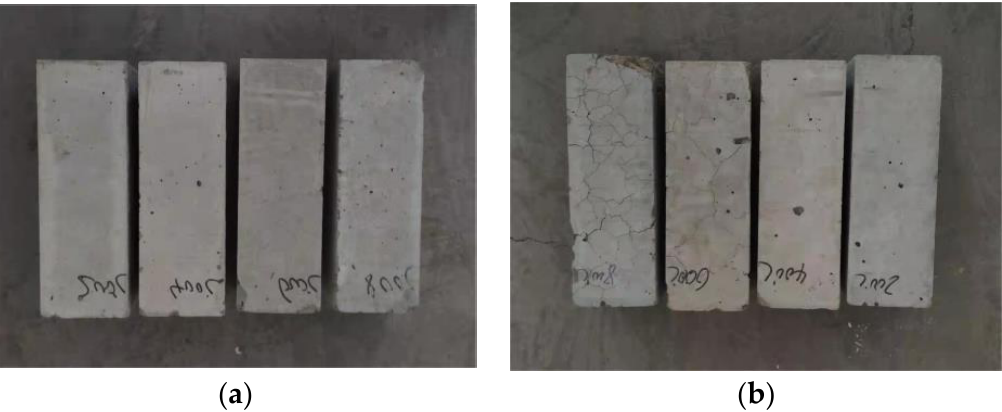
Figure 3. The changes in the color and surface cracks of specimens after high temperatures: ( a ) SAC, ( b ) NC.